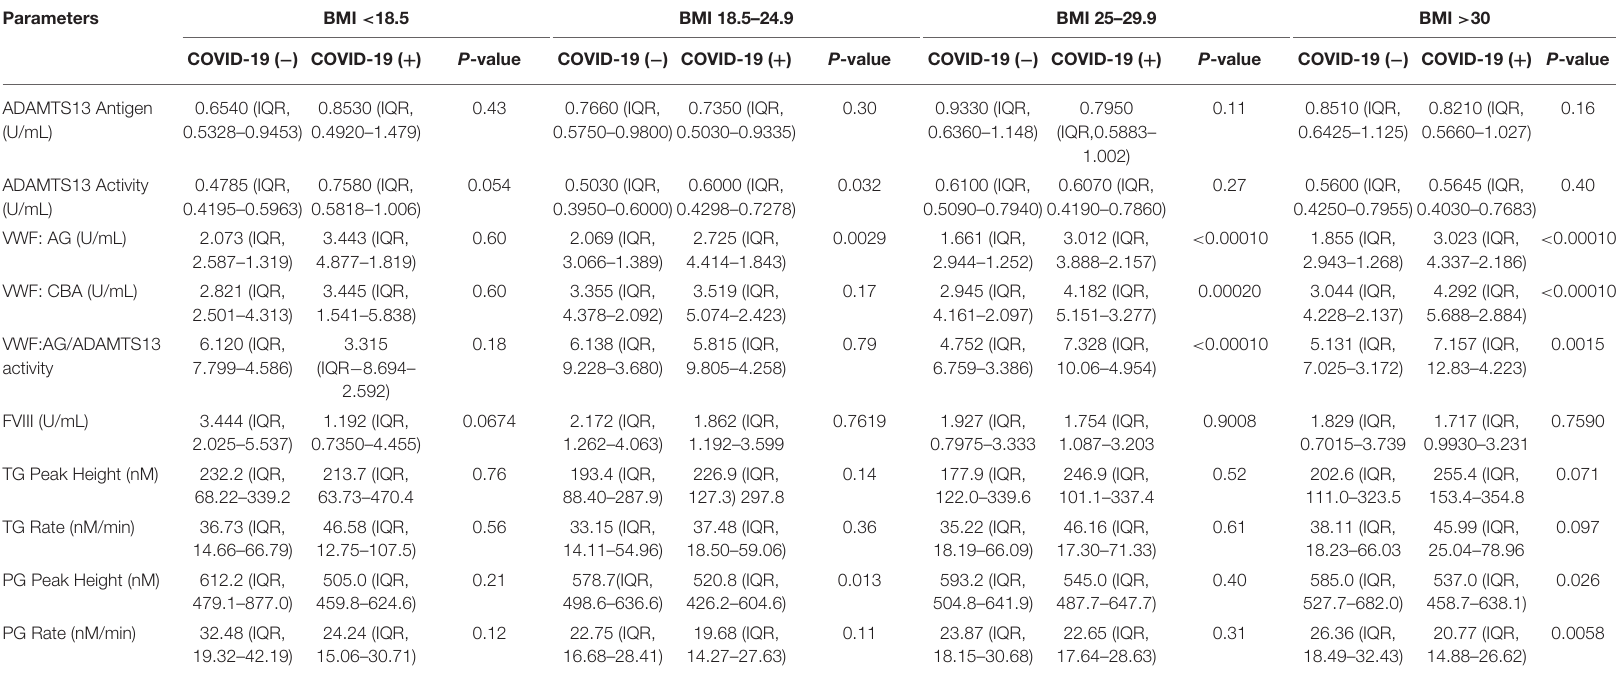
TABLE 3 | VWF, ADAMTS13, thrombin generation, and plasmin generation characteristics by BMI groupings.